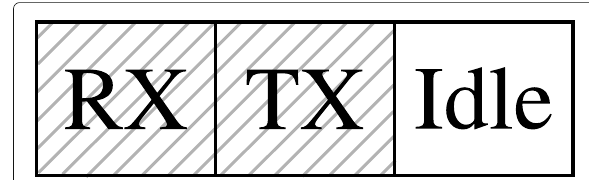
Fig. 14 A schedule with unreachable states σ n 1,2